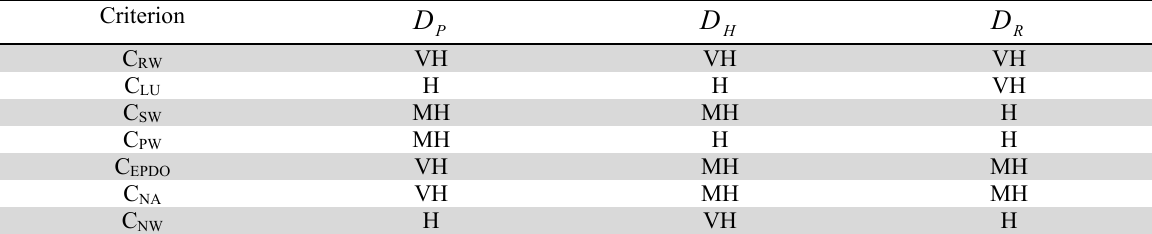
The weights given to different criteria